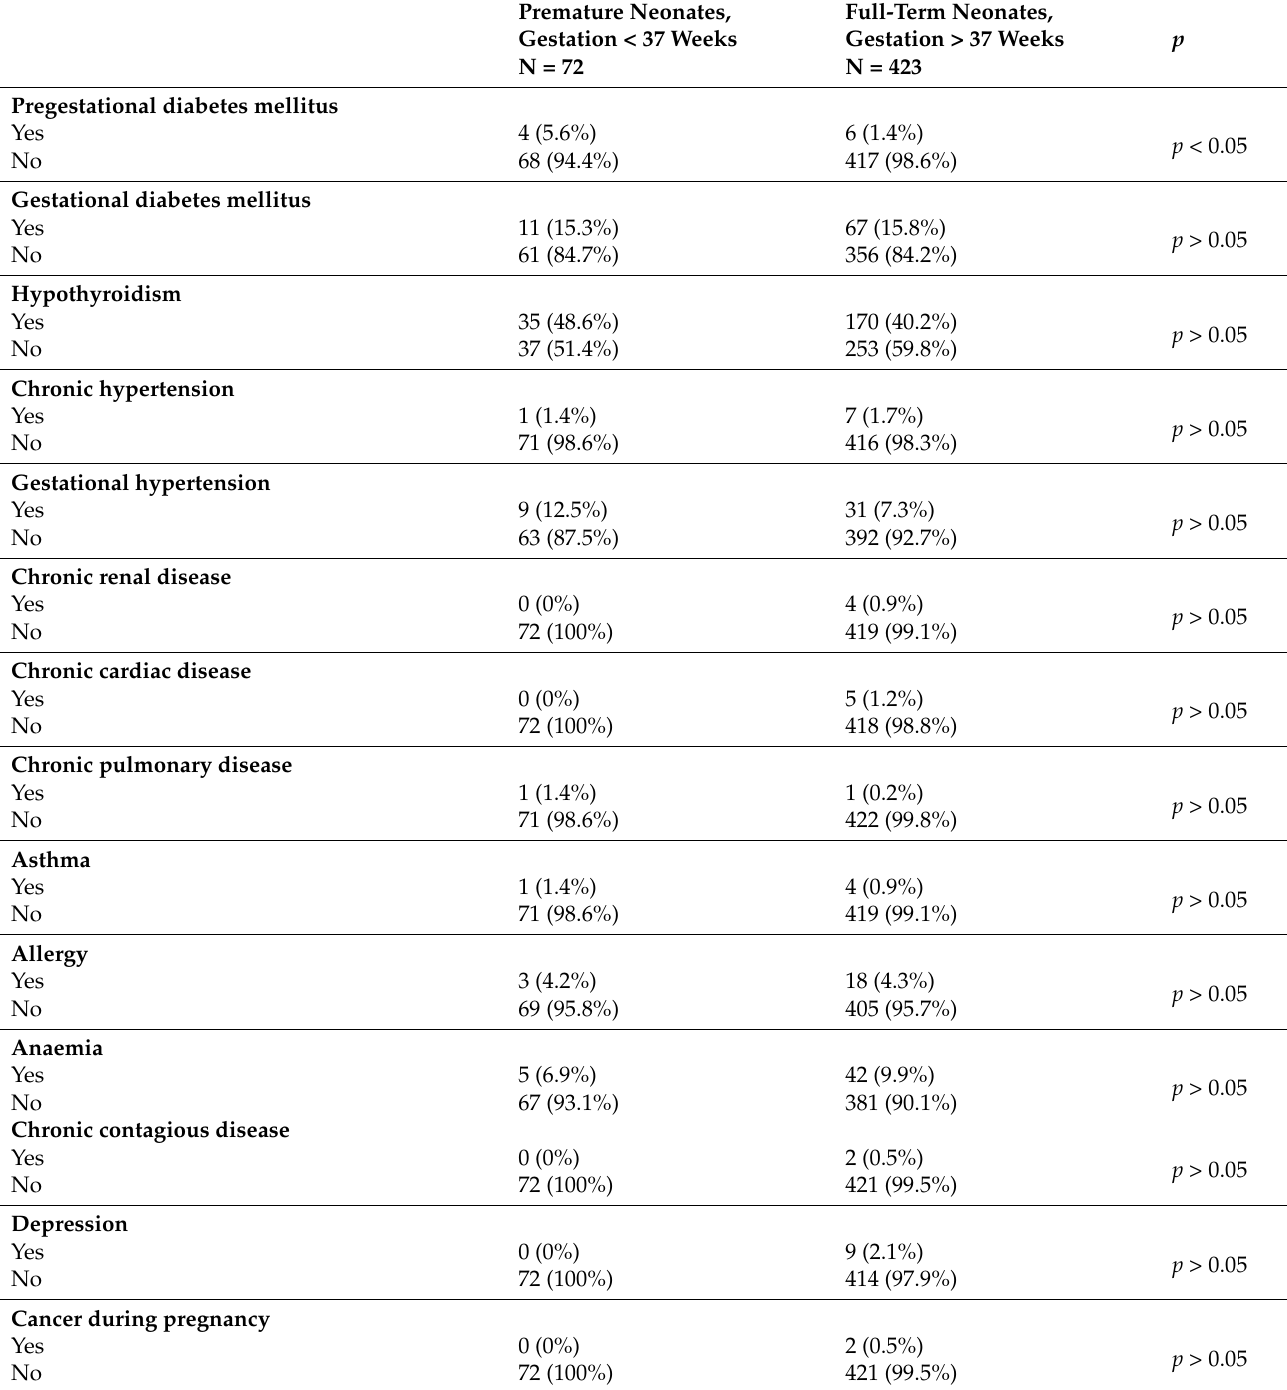
Table 2. Adverse pregnancy